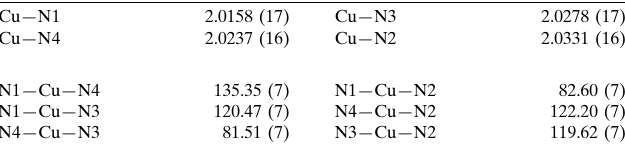
Selected geometric parameters (A˚ , (cid:1)